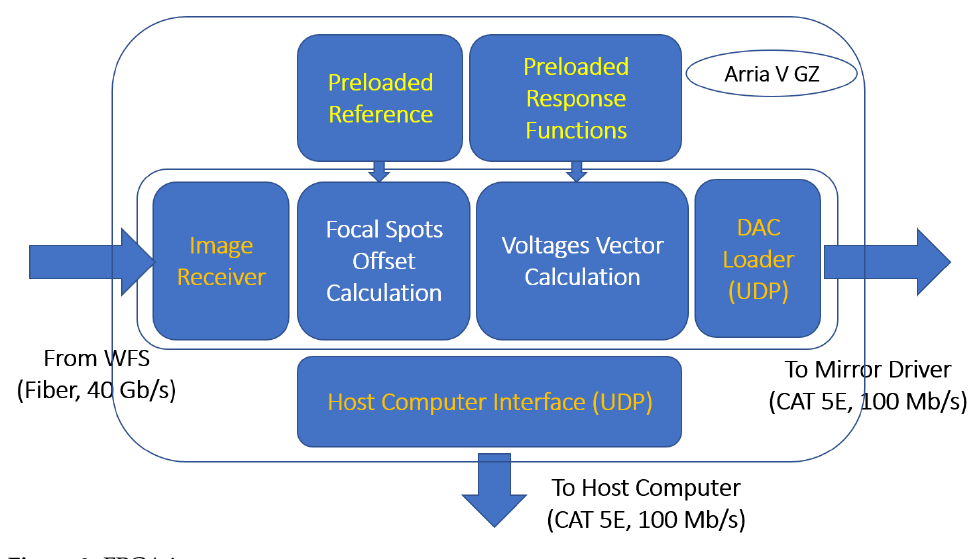
Figure 3. FPGA inner structure.